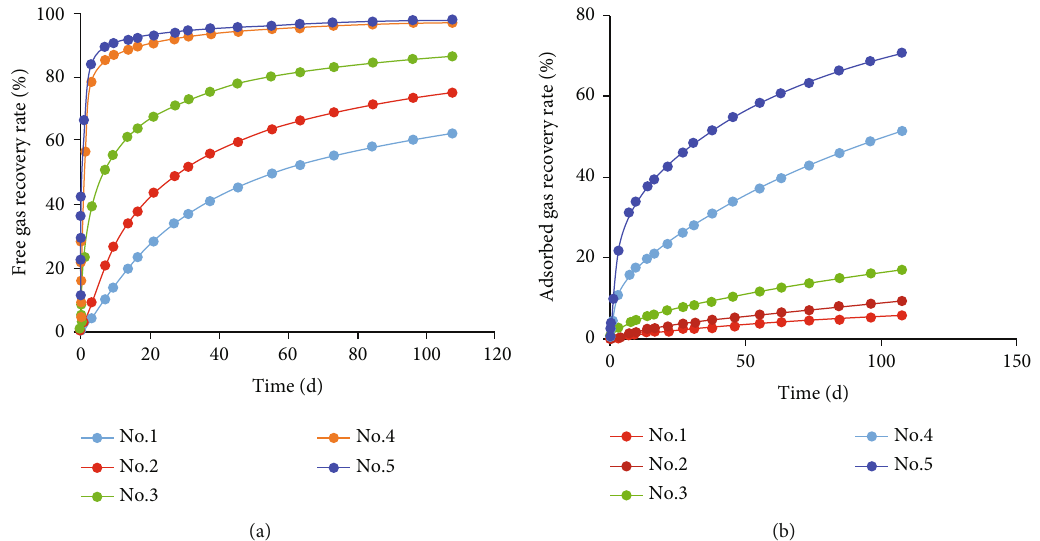
Figure 9: The free gas and adsorbed gas recovery rate from matrix blocks at di ff erent distances from the fracture surface.